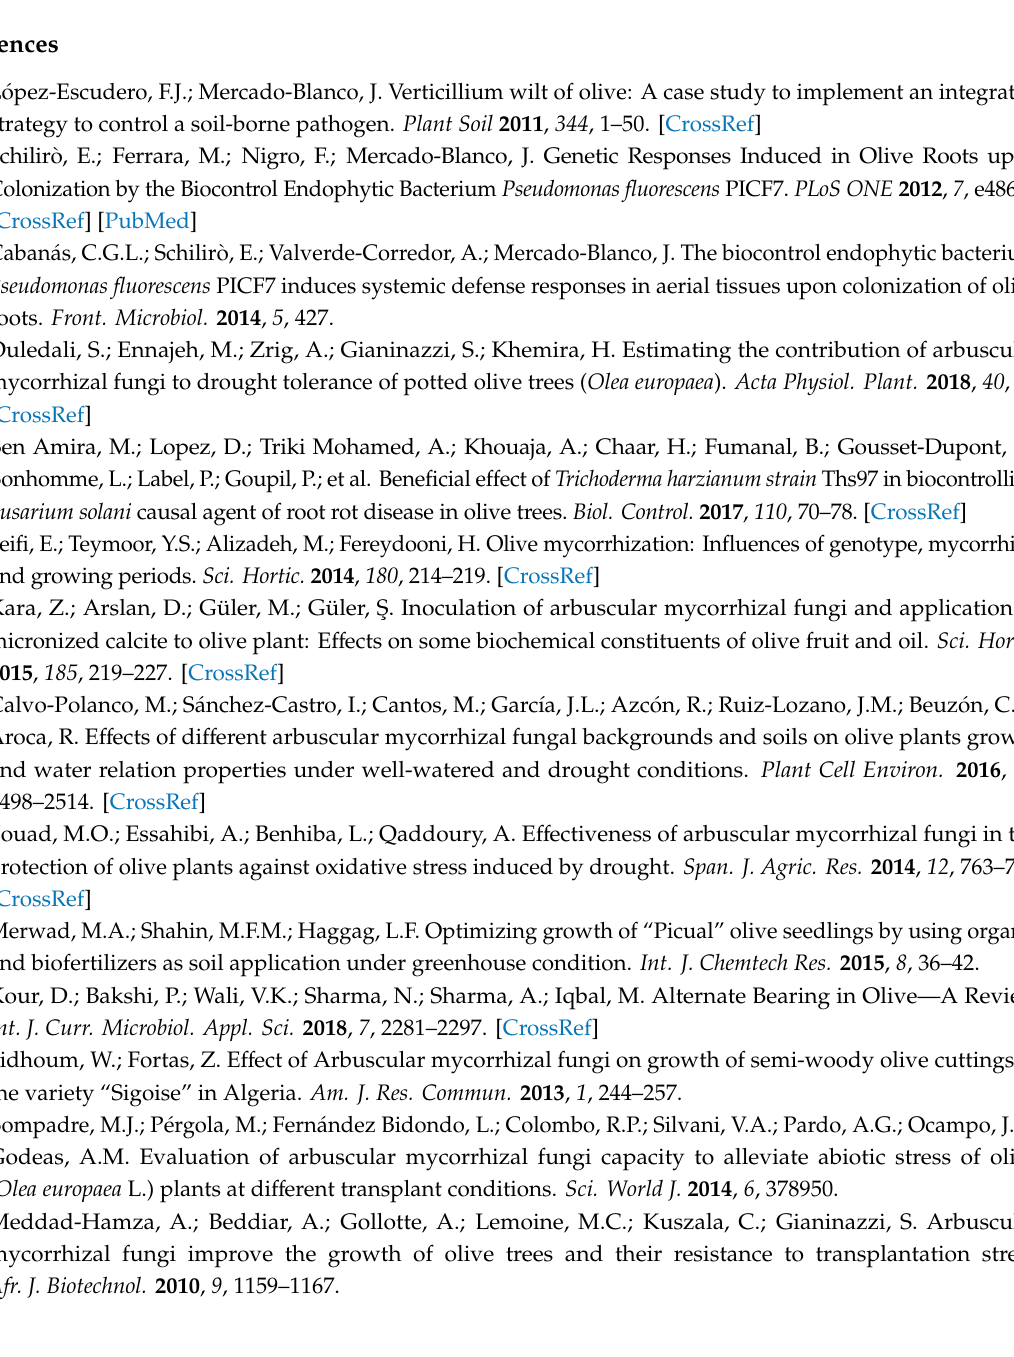
Table S1: List of all the research articles used in our